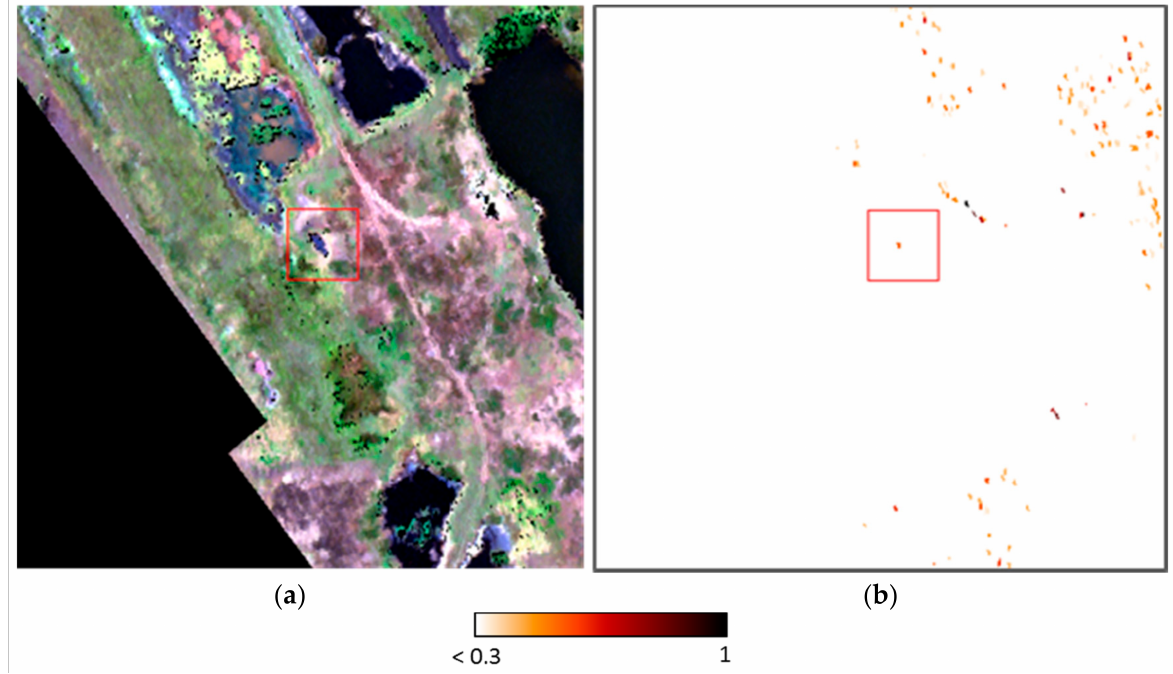
Figure 17. RGB HySpex image ( a ). Normalized Area1700 with modified upper wavelength ( b